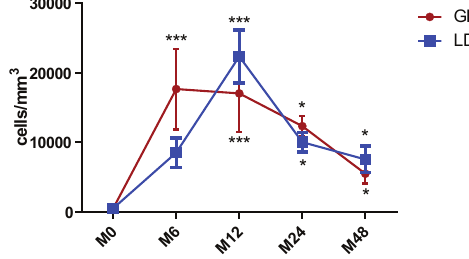
FIGURE 1 - WBC count observed at 0, 6, 12, 24 and 48 hours after arthroscopy. Significant differences marked for *p<0.05 and ***p<0.01 versus